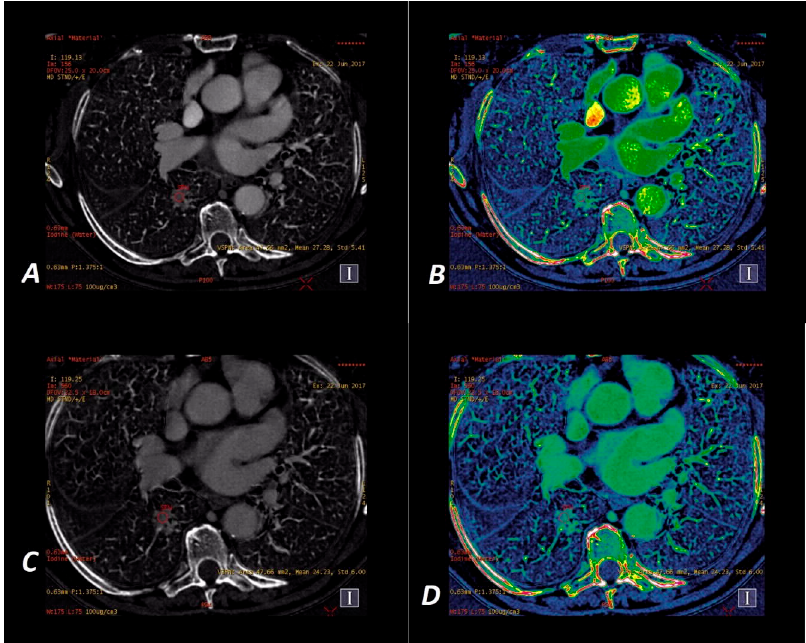
Figure 4. A 65-year-old woman with adenocarcinoma. Iodine–based SS DECT images in AP ( A , B ) and VP ( C , D ). Iodine material density ssDECT image shows the iodine content in the region that shows hyperattenuation in SPN on Figure 2a,c. Colormap “French” ( B , D ) helps to identify the tumor compared to their standard “Linear Gray” map ( A,C ). Iodine concentration mean = 27.28 × 100 µg/cm 3 (AP) and 24.23 × 100 µg/cm 3 (VP). J. Clin. Med. 2020 , 9 , x FOR PEER REVIEW